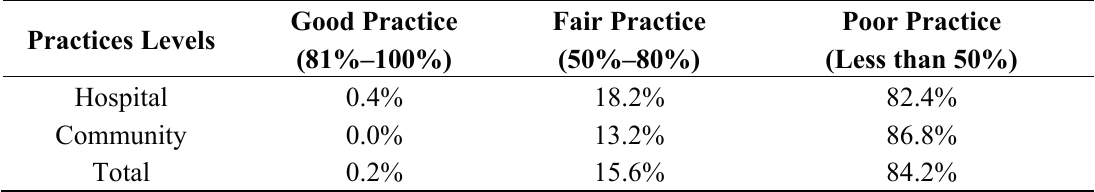
Table 5. Distribution of practices towards protecting children’s respiratory health .